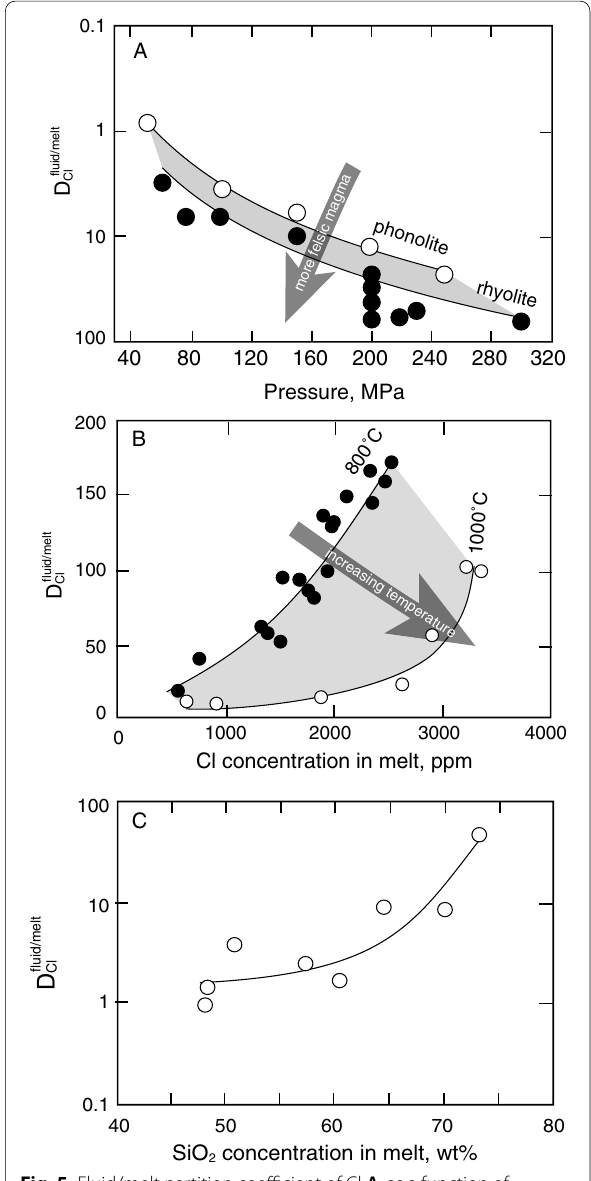
Fig. 5 Fluid/melt partition coefficient of Cl A . as a function of pressure for two different magma compositions as indicated. B . As a function of Cl concentration in andesitic melt at two different temperatures as indicated, and C . as a function of SiO 2 concentration in melt. Modified from Botcharnikov et al. (2015) and Beermann et al.